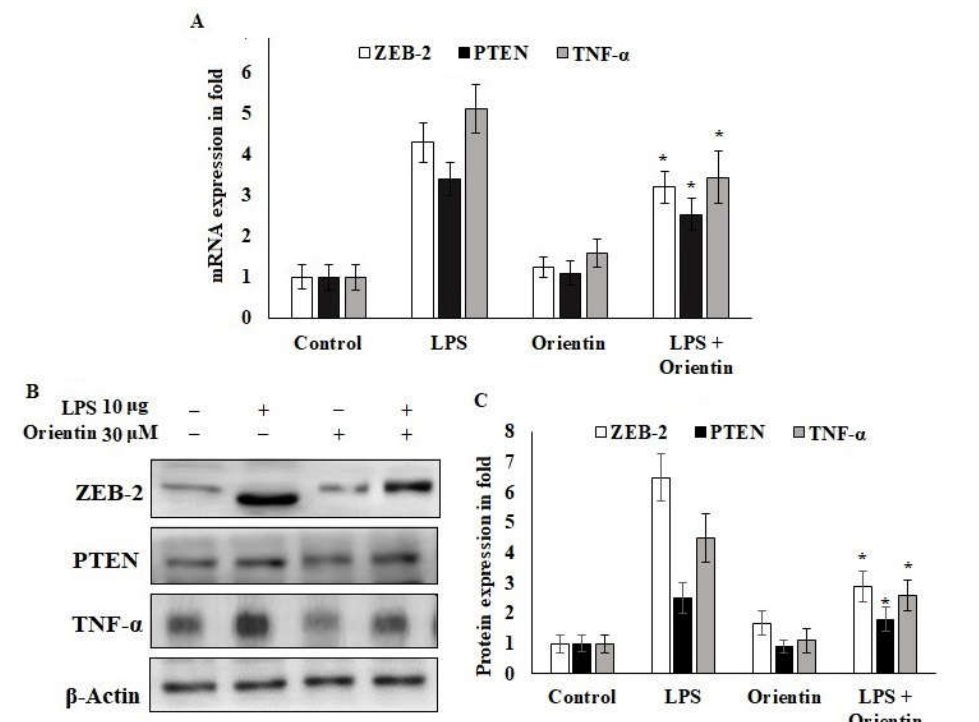
Figure 7. Effect of orientin on hepatic fibrotic signaling markers ZEB-2 and PTEN. Naïve mouse-derived HSCs were stimulated with LPS 10 ng for 2 h and treated for 12 h with orientin (30 μM). Treated cells were evaluated for ZEB-2, PTEN, and TNF-α mRNA and protein were quantified. ( A ) mRNA quantification of ZEB-2, PTEN, and TNF-α in LPS-stimulated HSCs and LPS with orientin-treated cells was undertaken using SYBR green-based real time PCR assay. ( B , C ) Protein quantification of ZEB-2, PTEN, and TNF-α in LPS-stimulated HSCs and LPS with orientin (30 μM)-treated cells using immunoblot-based techniques. Values are expressed as three independent experiments and all values are expressed as mean ± SD. * Represents the significant comparison with the control and LPS-induced groups.